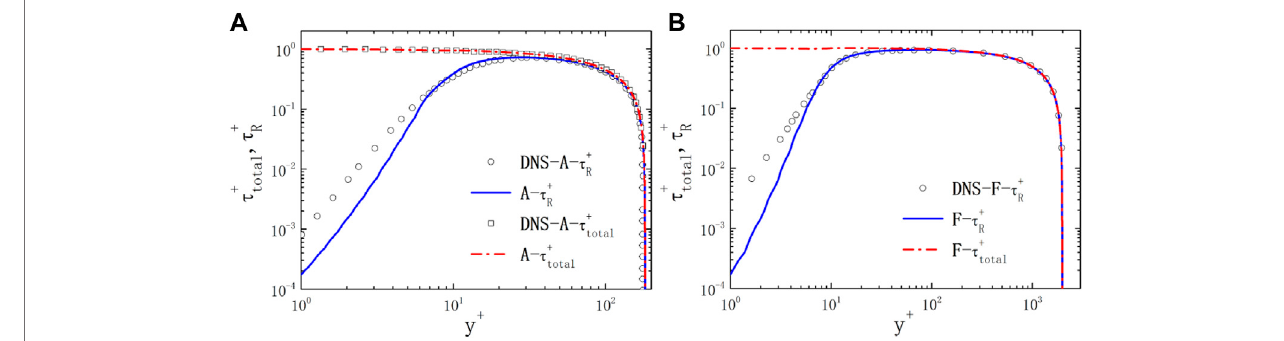
FIGURE 2 | Non-dimensional stress of the plane. (A) case A; (B) case F.